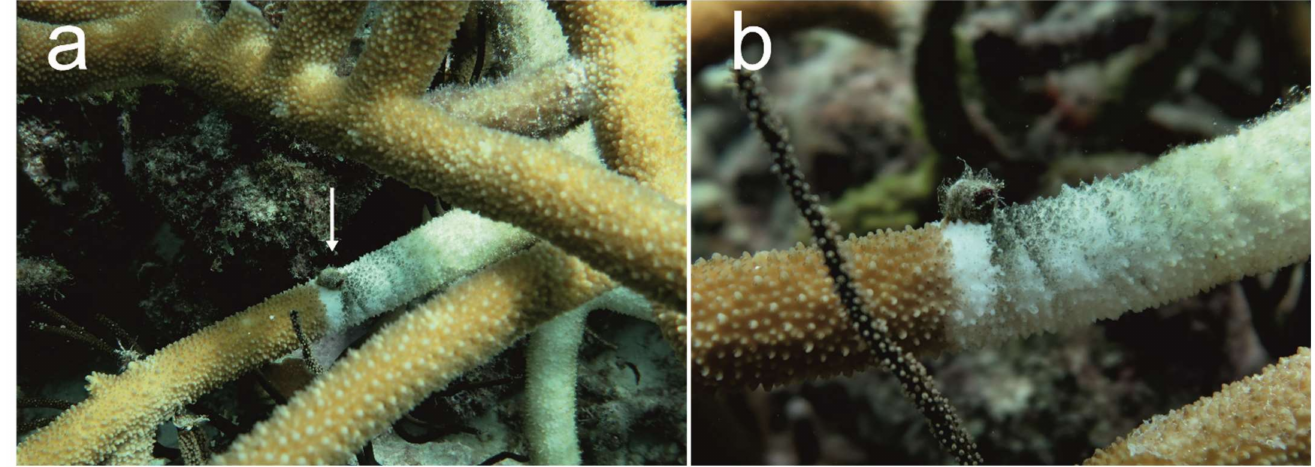
Figure 2. ( a ) Coralliophila sp. snail feeding in proximity of cluster of ciliates forming the typical disease band of CCI; ( b ) close-up of the snail’s feeding